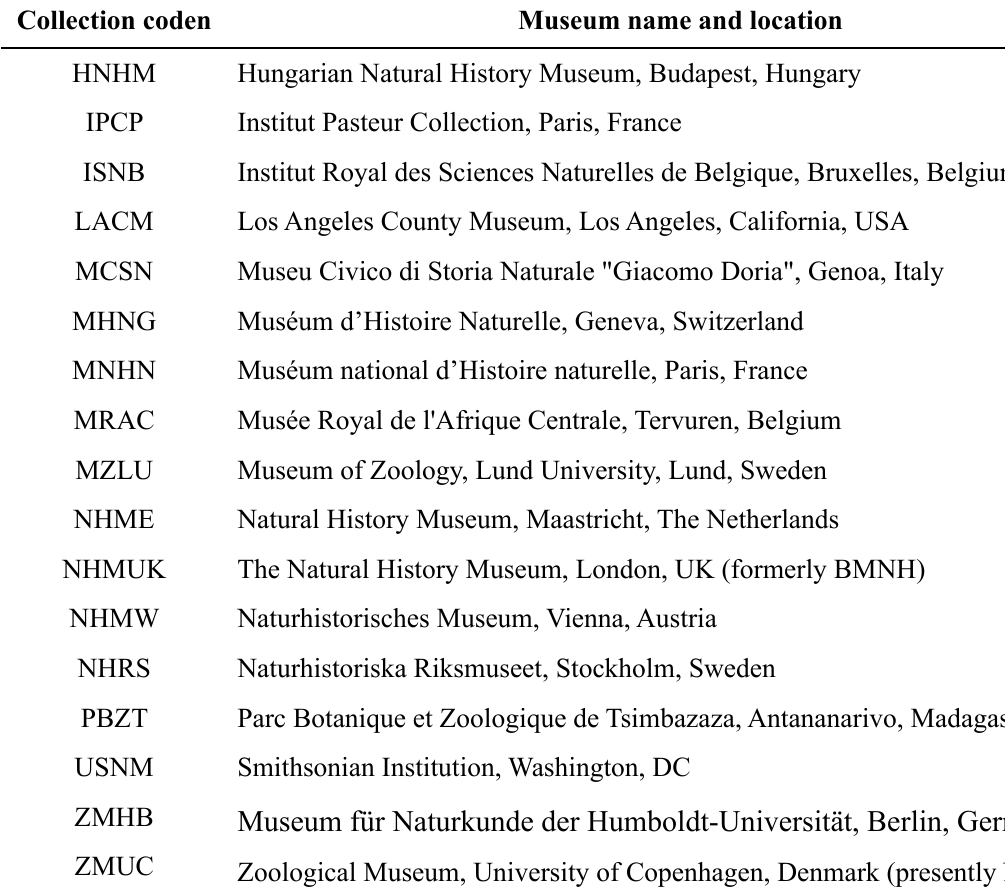
Table 1. A list of all museum repositories and their corresponding collection codens, updated from Johnson & Musetti (2004) and Arnett et al .